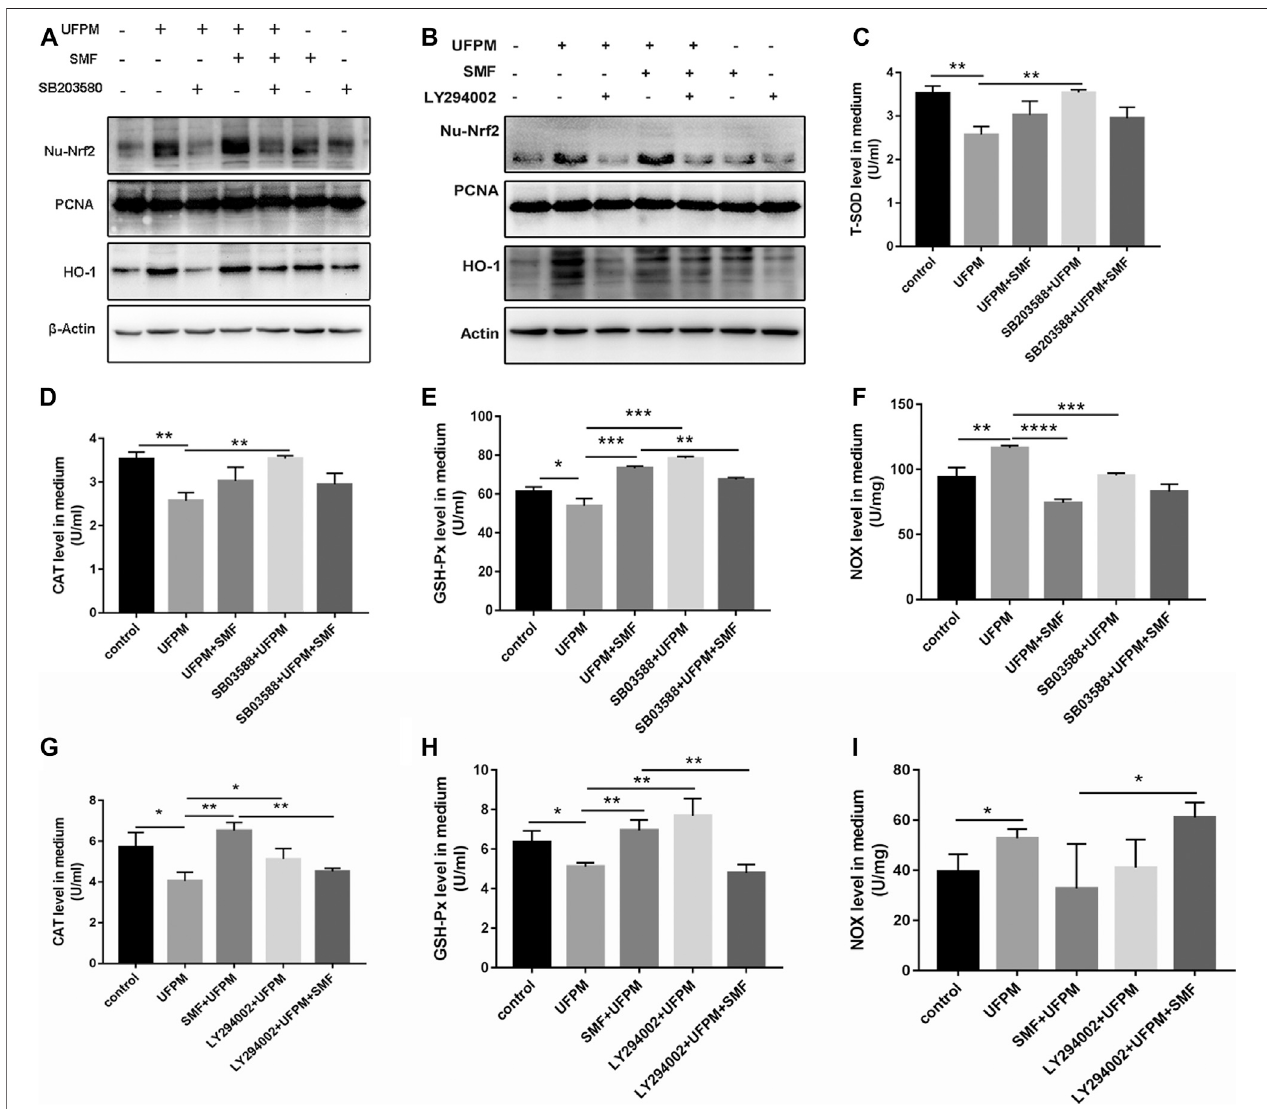
FIGURE 8 | SB 203580, LY294002 and SMF inhibit UFPM-induced HO-1 and Nrf2 expression and T-SOD, CAT, NOX, and GSH-Px production. H9C2 pre- incubated with medium or SB 203580 (10 mM) for 60 min and LY294002 (50 μ M) for 4 h were cultured with medium or SMF for 24 h, and then treated with or without UFPM (50 mg/ml) for 6 h (A,B) Western blot analysis of HO-1 and Nrf2 expression in cells. T-SOD (C) , CAT (D,G) , GSH-Px (E,H) , and NOX (F,I) concentrations in the culture supernatants were determined 6 h after UFPM exposure. The results are expressed as the mean ± SD of three different experiments. Asterisks indicate signi fi cant differences by t -test, * p < 0.05, ** p < 0.01, *** p < 0.001.